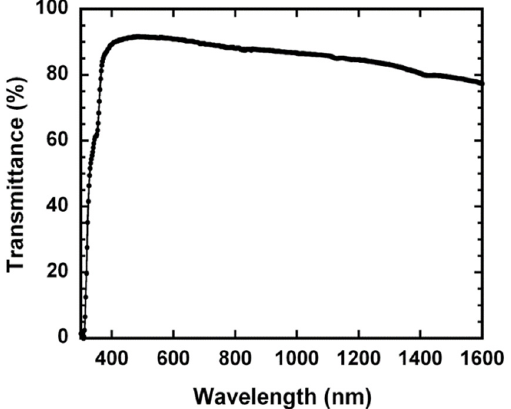
Figure 2. Optical transmittance of the + ‐ shape flexible strain sensors measured with a UV ‐ vis ‐ NIR spectrophotometer.